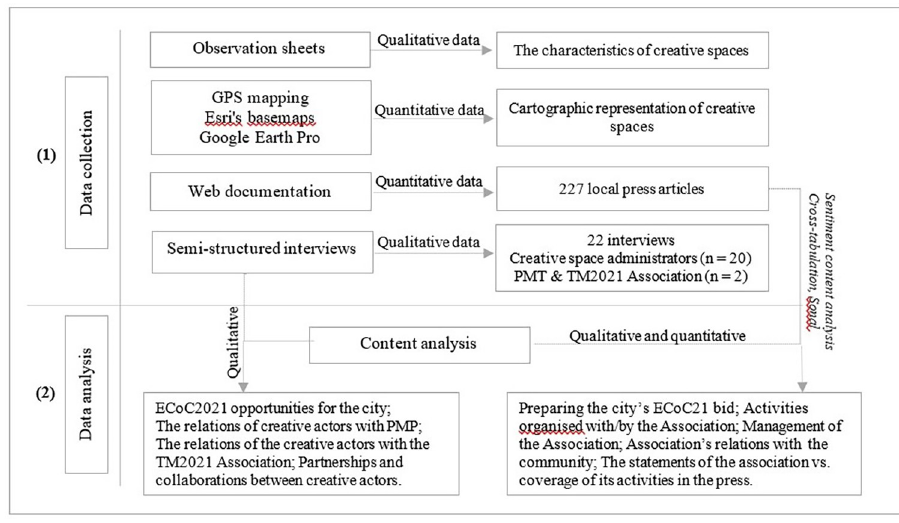
Fig 1. Design methodology flow